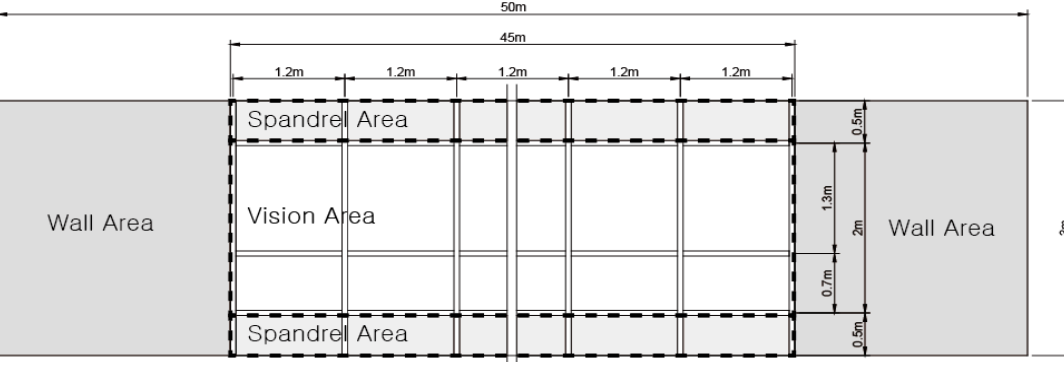
Figure 6. Detailed elevation of the analysis model. Table 11. Optical and thermal properties of the analysis model’s old curtain wall.